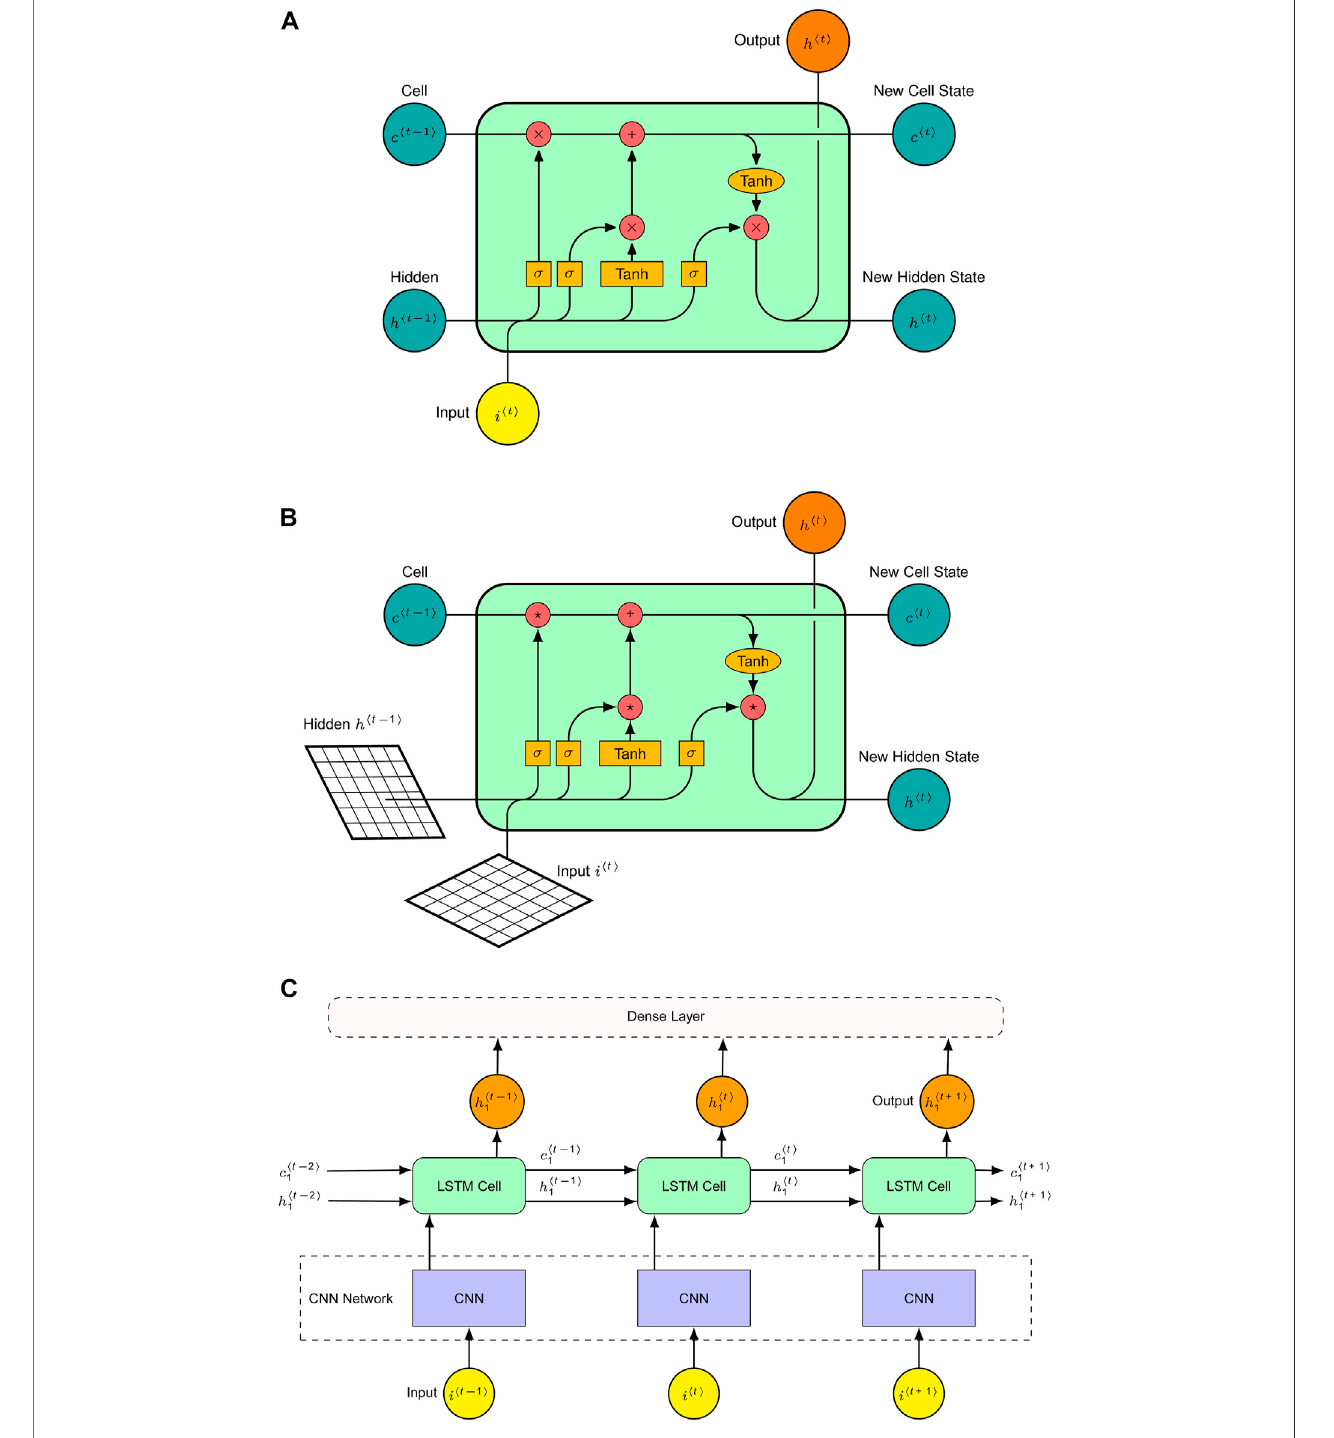
FIGURE5|(A) AlayerofthesimpleLSTMwiththreegates. (B) AConv-LSTMmodelwithaconvolutionoperationoninputandhiddenstate. (C) ACNN-LSTMwith a CNN network at an input layer.